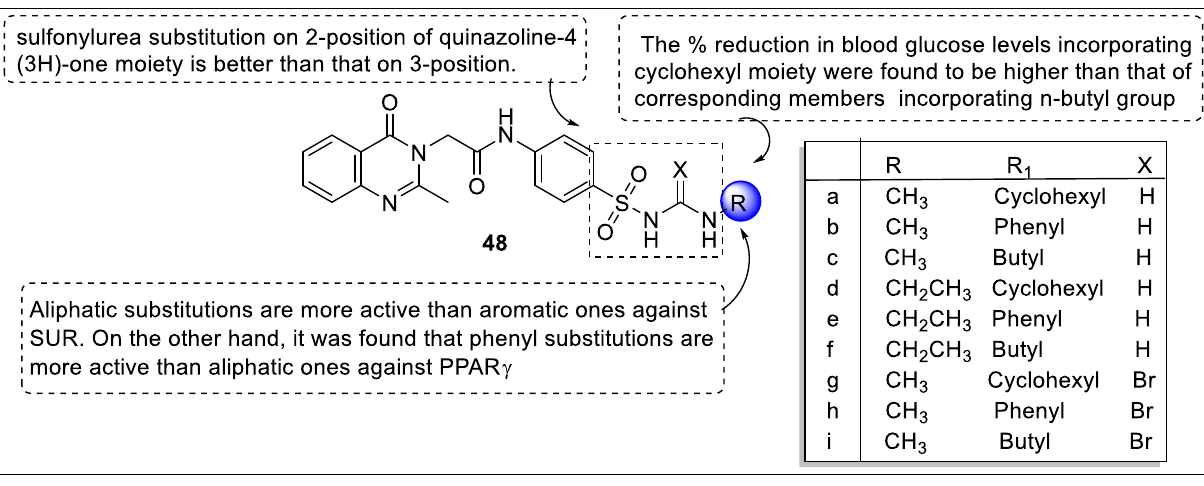
Figure 52. Structural activity relationship of quinazoline hybrids ( 48 ) as potent PPAR ligands.